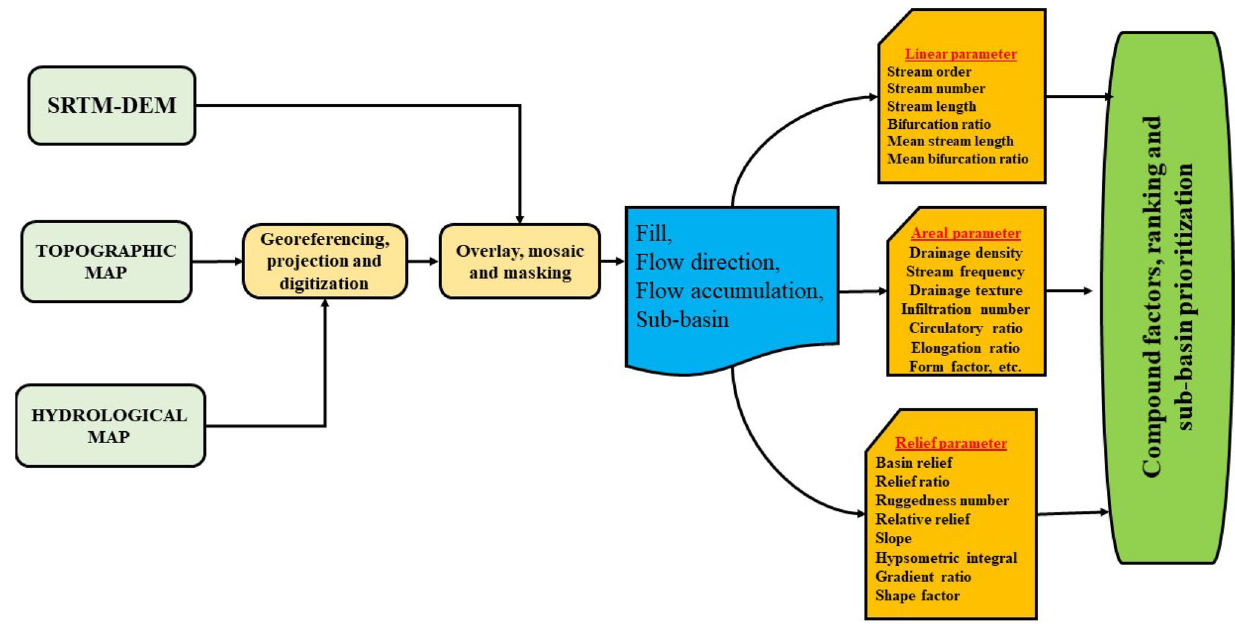
Fig. 2 Flow chart for the